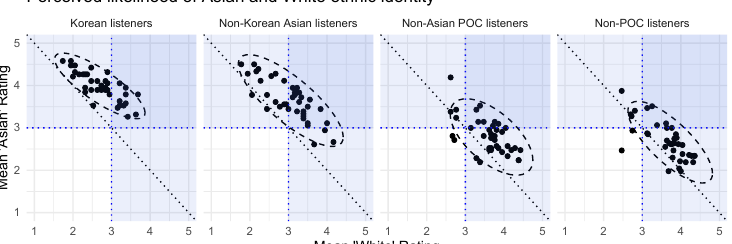
Figure 5. All four listener groups (Korean n = 19, non-Korean Asian n = 18, non-Asian POC n = 24, White n = 44) demonstrated a robust negative correlation between perceived Whiteness and perceived Asianness. Asian listeners were more likely to perceive the speakers as Asian, while non-Asian listeners (whether POC or White) were more likely to perceive the speakers as